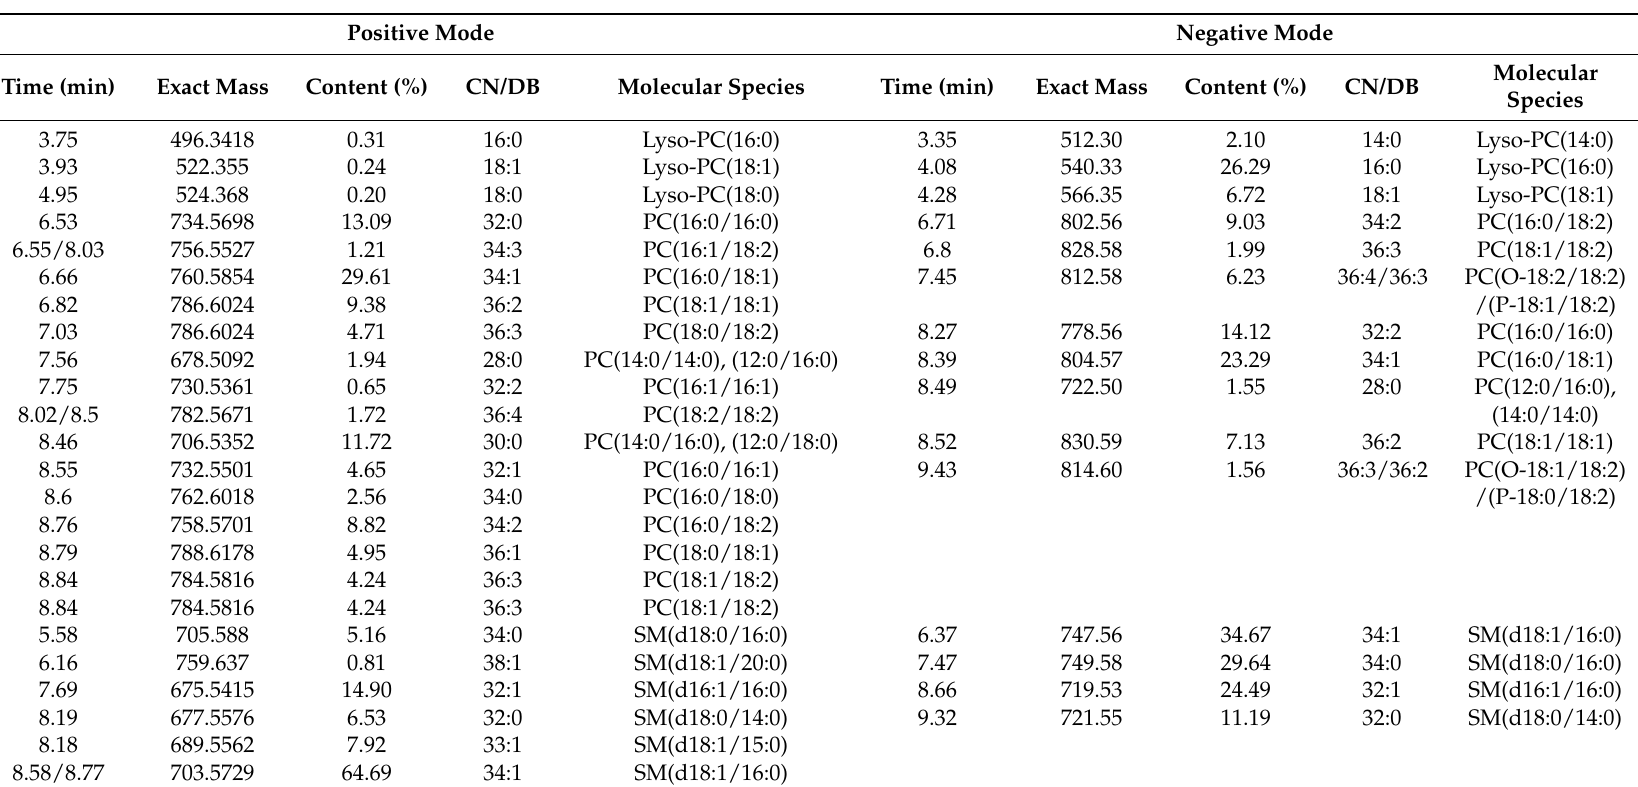
Table 4. Phosphatidylcholine (PC) and sphingomyelin (SM) content in the F1 fraction of buttermilk as determined by UPLC/QToF-MS. The acyl chain compositions of the molecular species are